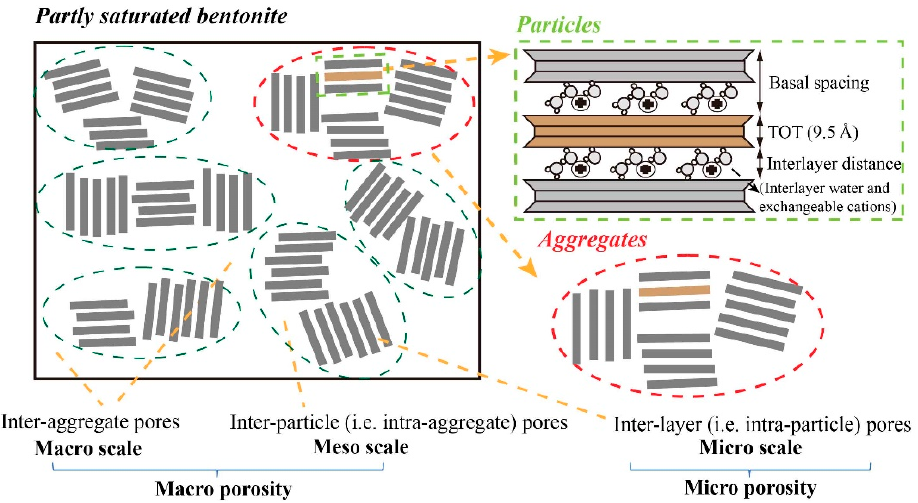
Figure 2. Conceptual diagram of pore system of compacted